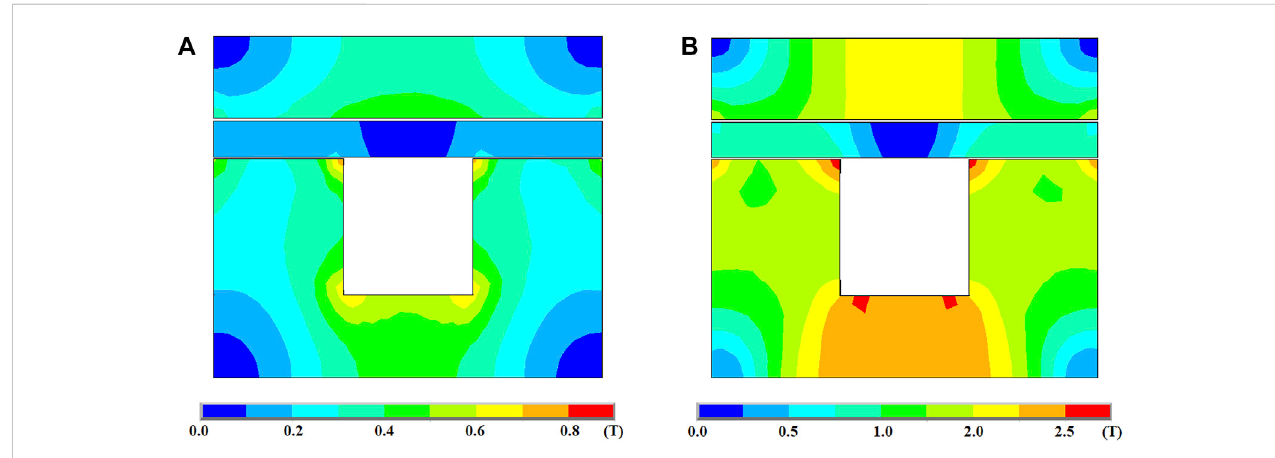
FIGURE 7 Magnetic fi eld simulation of magnetic controlling unit coupled with MRE railway pad at 1A (A) and 5A (B) .